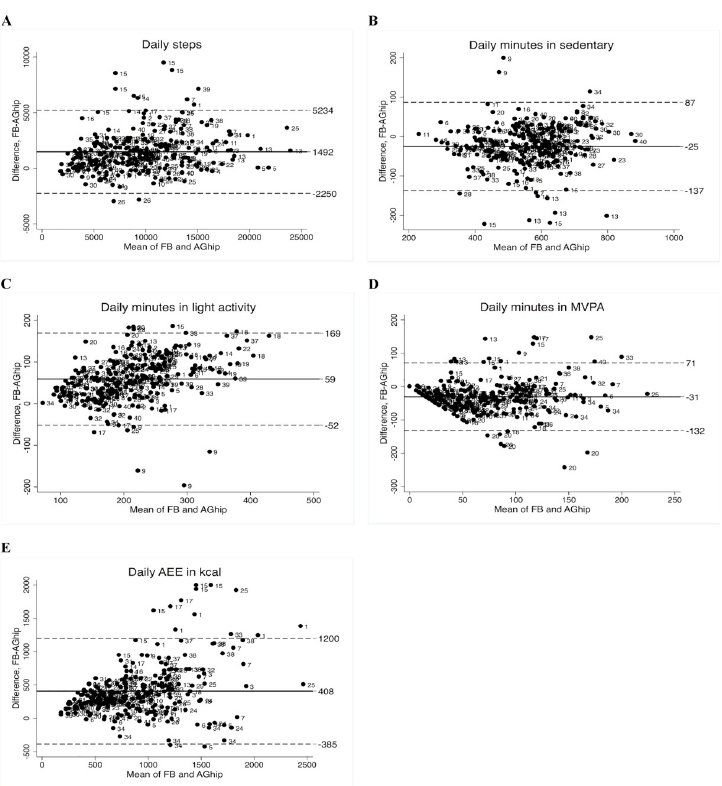
Fig 1. Bland-Altman plots of differences between wrist-worn Fitbit Charge 2 and hip-worn ActiGraph against the mean on: (A) Steps, (B) Time in sedentary, (C) Time in light activity, (D) Time in MVPA, and (E) AEE. The bold lines represent mean of the differences between devices, the dashed lines are the 95% limits of agreement. The numbers in the plot represent each subject. Abbreviation’s: FB, Fitbit Charge 2; AGhip, ActiGraph GT3X worn on the hip; MVPA, moderate-to vigorous physical activity; AEE, active energy